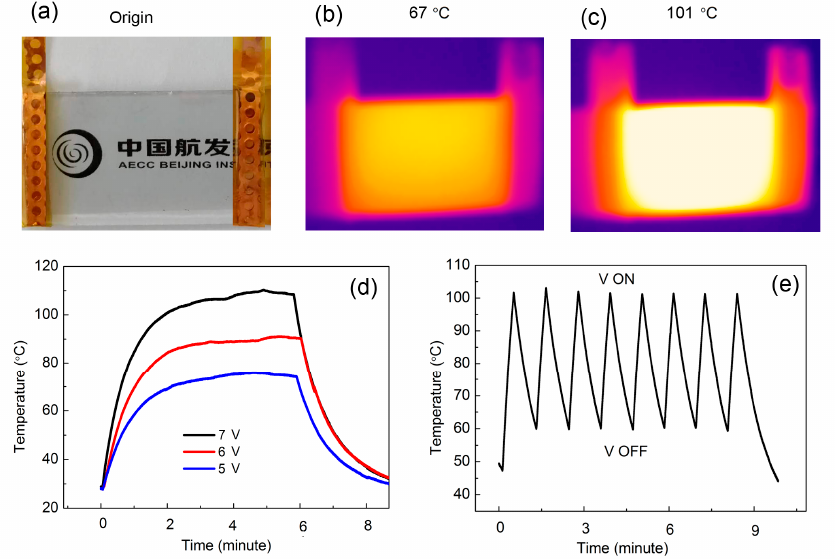
Figure 6. ( a ) Image of electrothermal sample. Electrothermal samples at ( b ) 67 °C and ( c ) 101 °C. ( d ) Sample temperature as a function of time under electrical heat and ( e ) temperature cycles with voltage ON and OFF.